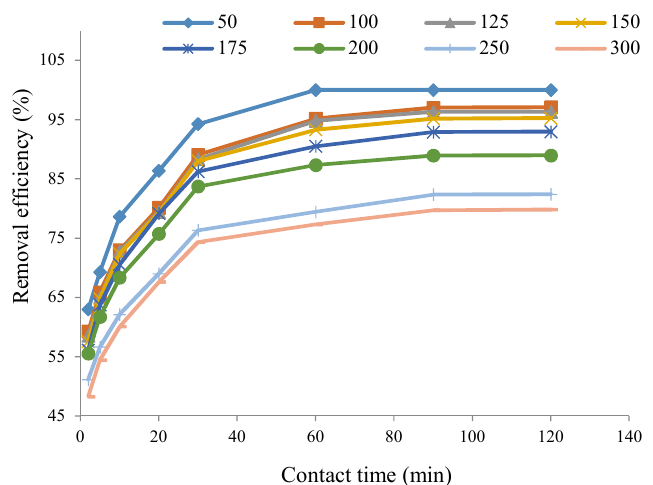
Fig. 8. Effect of initial ammonianitrogen concentration on removal efficiency (adsorbent dosage of 1.5 g, contact time of 120 min and pH= 9)